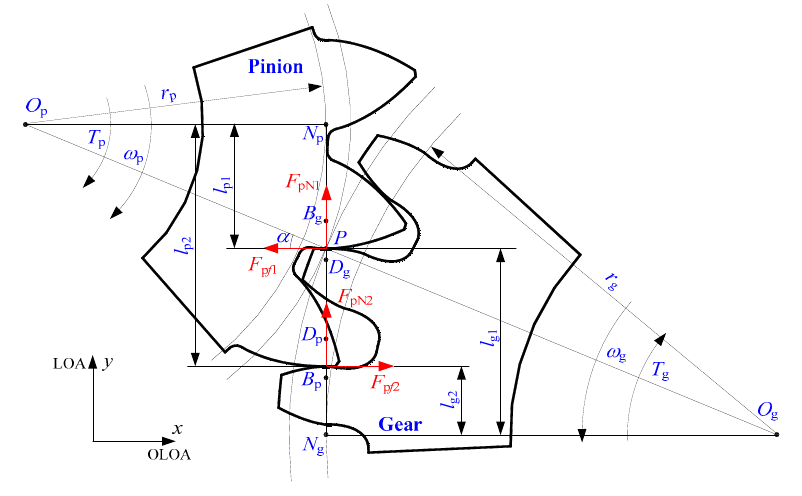
Figure 1. Meshing process of a spur gear transmission.